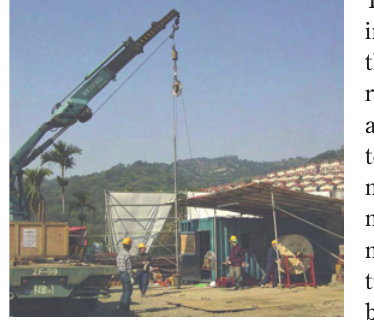
Figure 1. The precise temperature instrument that was installed in the well head of TCDP Hole